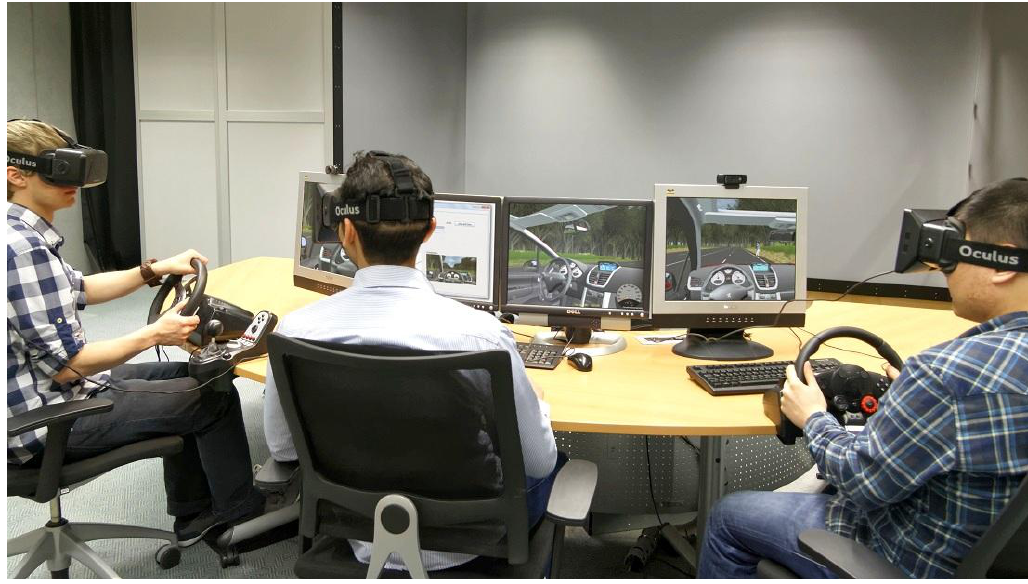
Figure 5. A prototype of the proposed training platform with multiple head-mounted displays.